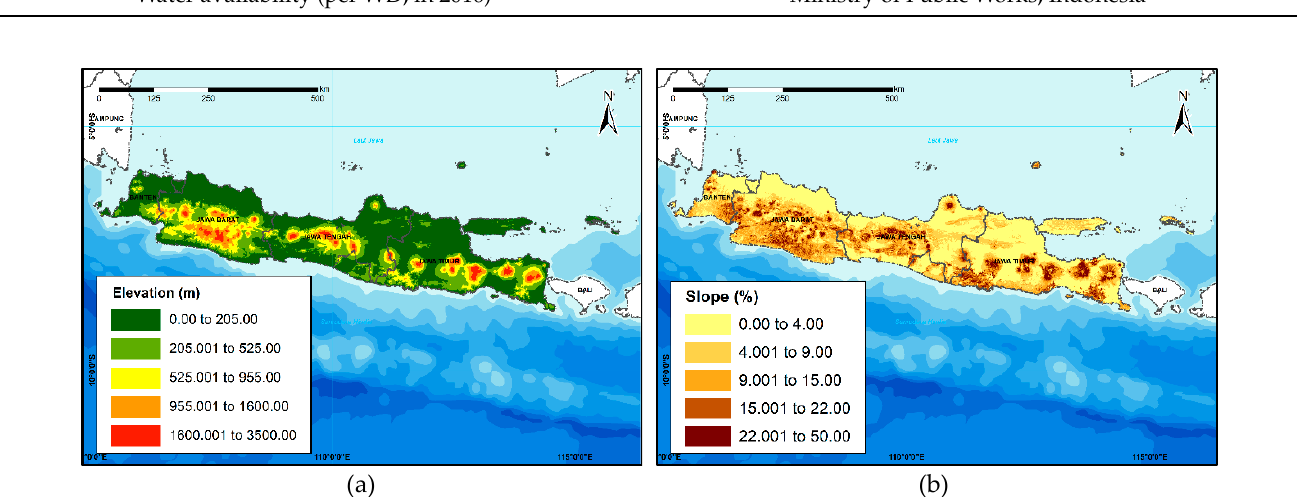
Figure 2. The topography parameters: elevation ( a ) and slope ( b ).